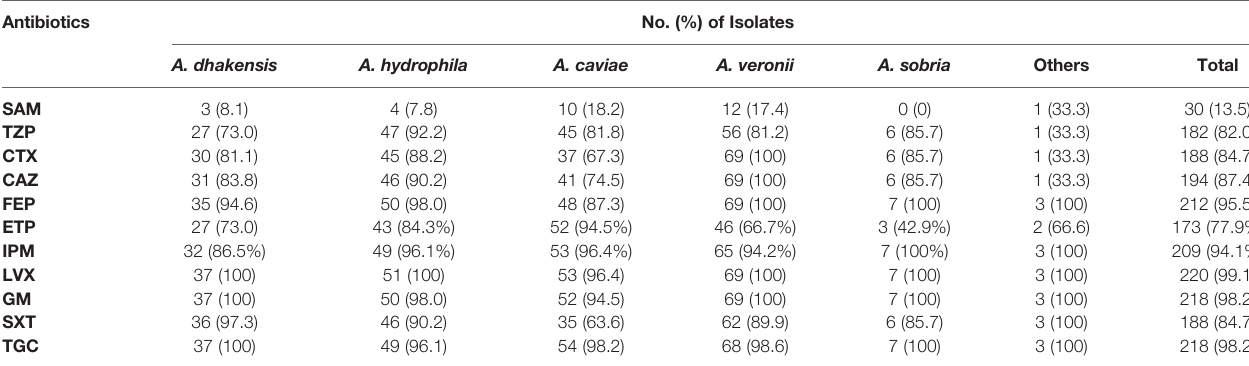
TABLE 4 | Antimicrobial susceptibility results of Aeromonas clinical